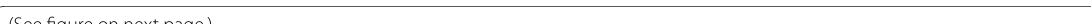
myelocystocele(See figure on next Fig. 3 Four-month-old male infant presented with ARM, lower back cystic swelling, and lower limb anomalies. A Plain AP radiograph of pelvis showing pronounced structural skeletal caudal defect in the form of hypoplastic left iliac and ischial bones, absent femur on left side with only femoral head and neck visualized on right side. B Axial T2WI showing dilated central canal (thin black arrow) within a dilated subarachnoid space herniating outside confines of spinal canal (thick black arrow) through defect in posterior element of S1 vertebra. Note also ectopic location of left testis in left aspect of anterior pelvic wall (white arrow) which corresponds to diffusion restriction seen in C . D Catheterization of single opening in upper perineum discharging urine revealed contrast opacification of distal bowel rectal loop with non-visualized urinary bladder in keeping with rectourethral fistula. E Panoramic sagittal USG image showing tethered cord with herniating dilated central canal (thin white arrow) within a meningocele (thick white arrow) through defect in upper sacral vertebra giving cyst within cyst appearance. Type of spinal dysraphism: Terminal